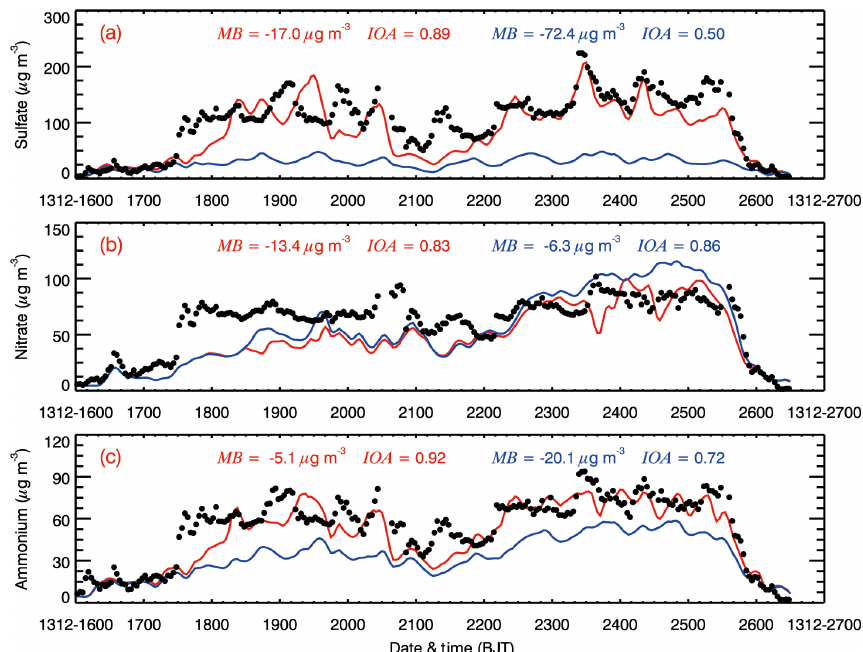
Figure 11. Comparison of measured and simulated diurnal profiles of inorganic aerosols of (a) sulfate, (b) nitrate, and (c) ammonium in Xi’an from 16 to 27 December 2013. The black dots represent the observations, and the solid red and blue lines denote the simulations in the E-case and B-case, respectively.